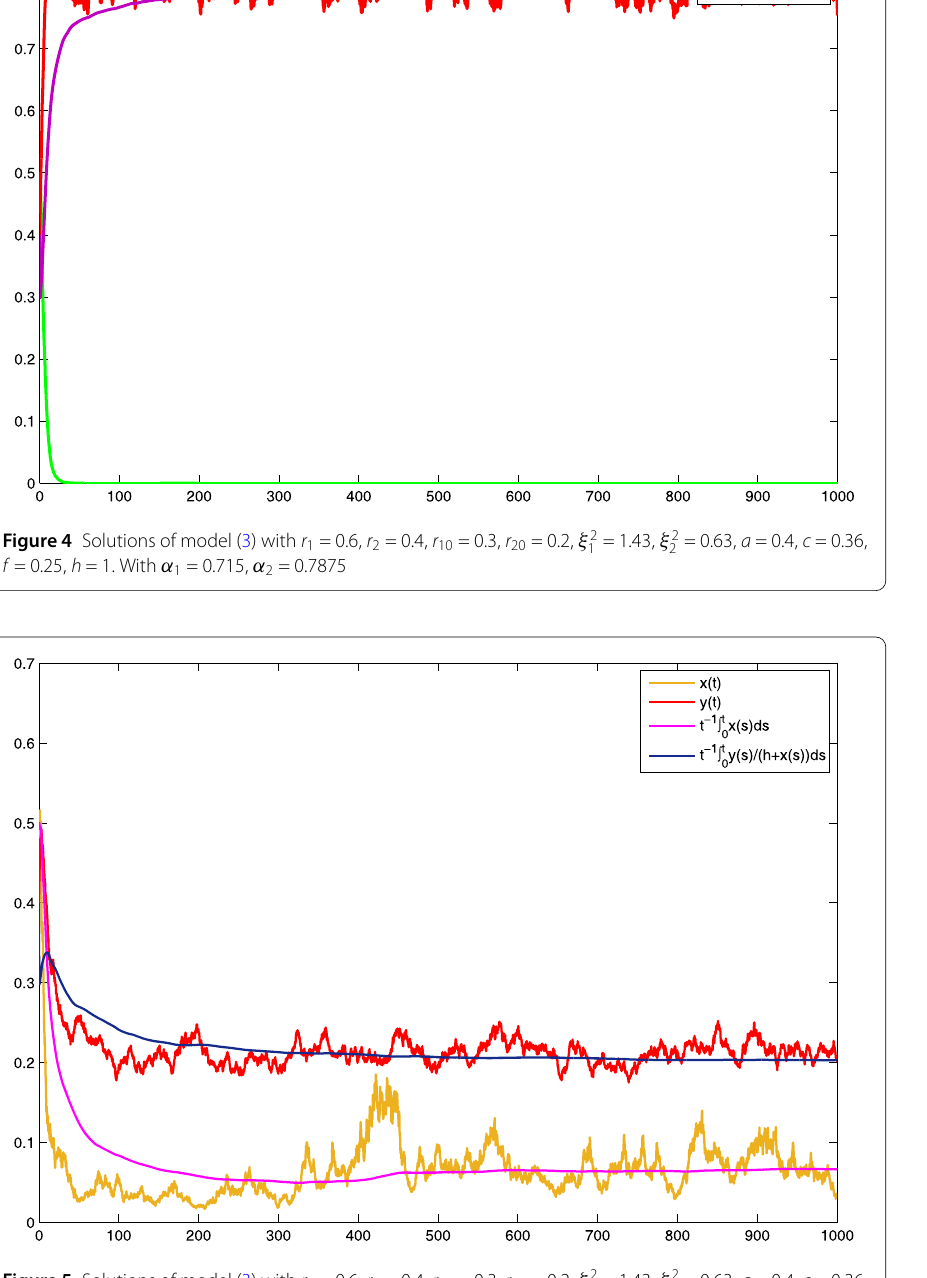
Figure 5 Solutions of model (3) with r 1 = 0.6, r 2 = 0.4, r 10 = 0.3, r 20 = 0.2, ξ 2 1 = 1.43, ξ 2 2 = 0.63, a = 0.4, c = 0.36, f = 0.25, h = 1. With α 1 = 0.715, α 2 =